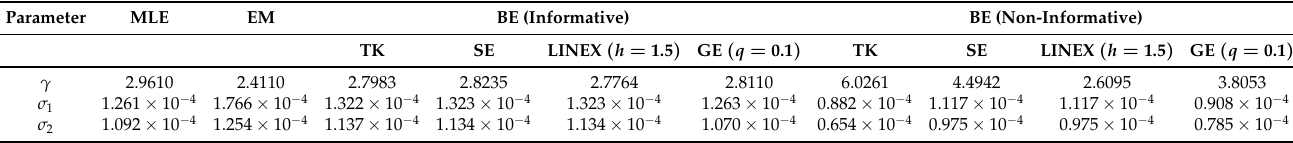
Table 6. MLEs and BEs for the parameters of application